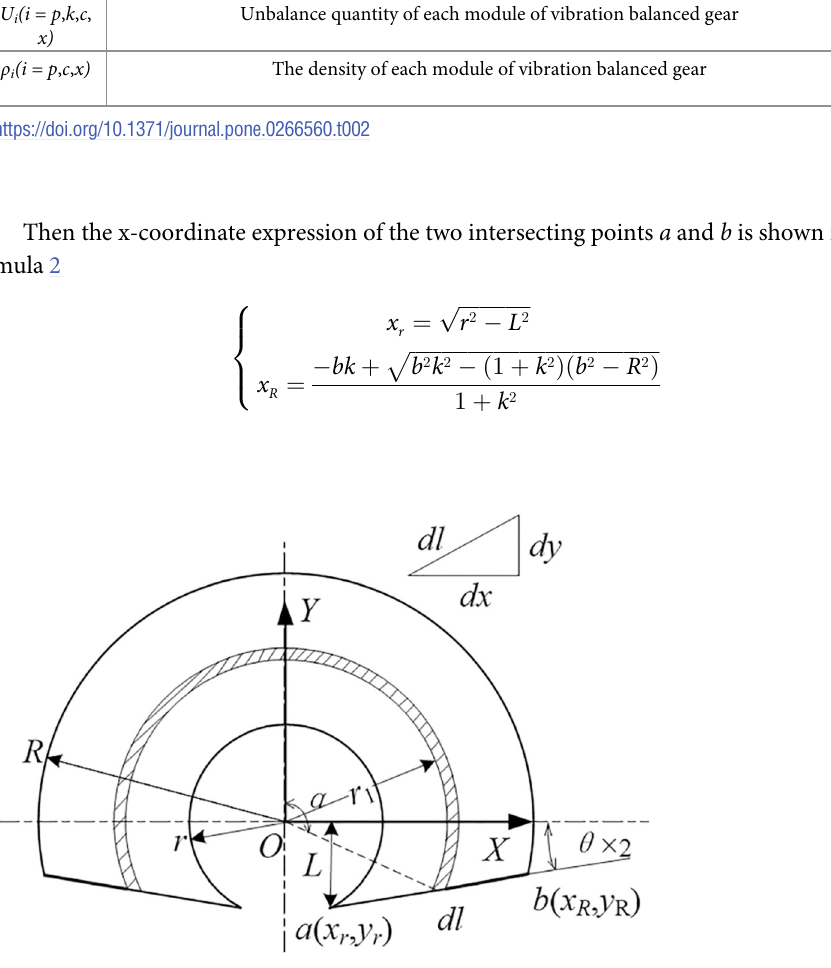
Fig 5. Plane characteristics of weight-increasing